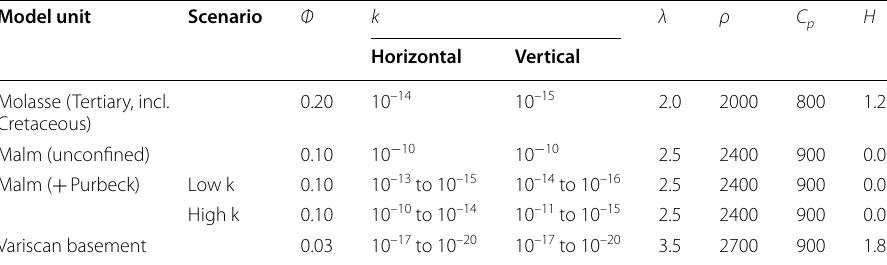
Table 1 Properties of model units